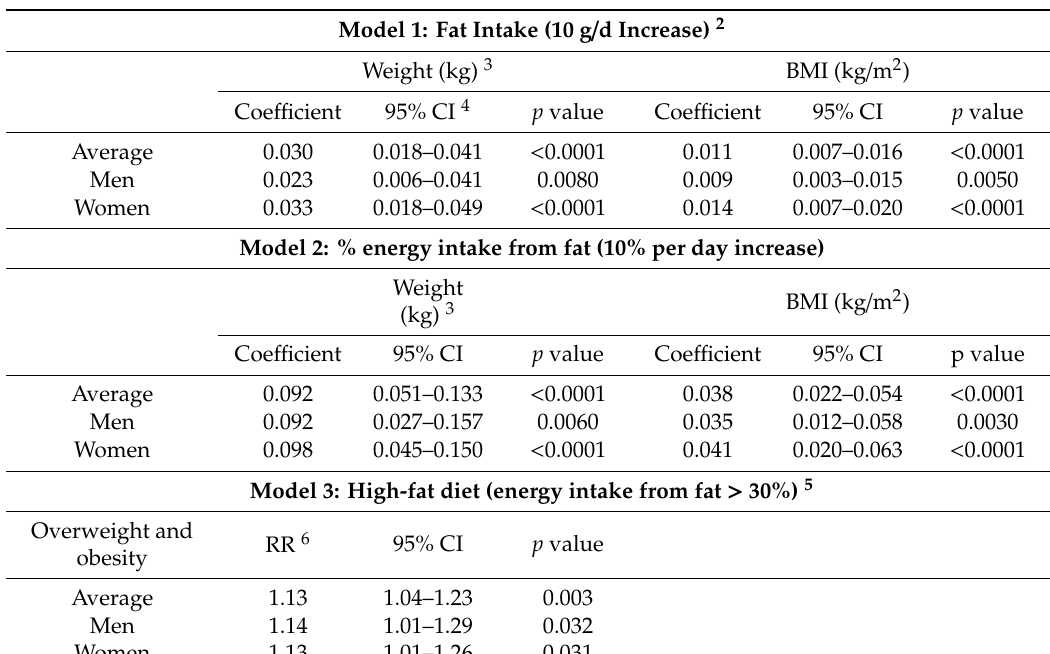
Table 3. Associations of fat intake and percentage of energy intake from fat with body weight, BMI, and the risk of overweight and obesity, China Health and Nutrition Survey, 1991–2015 1